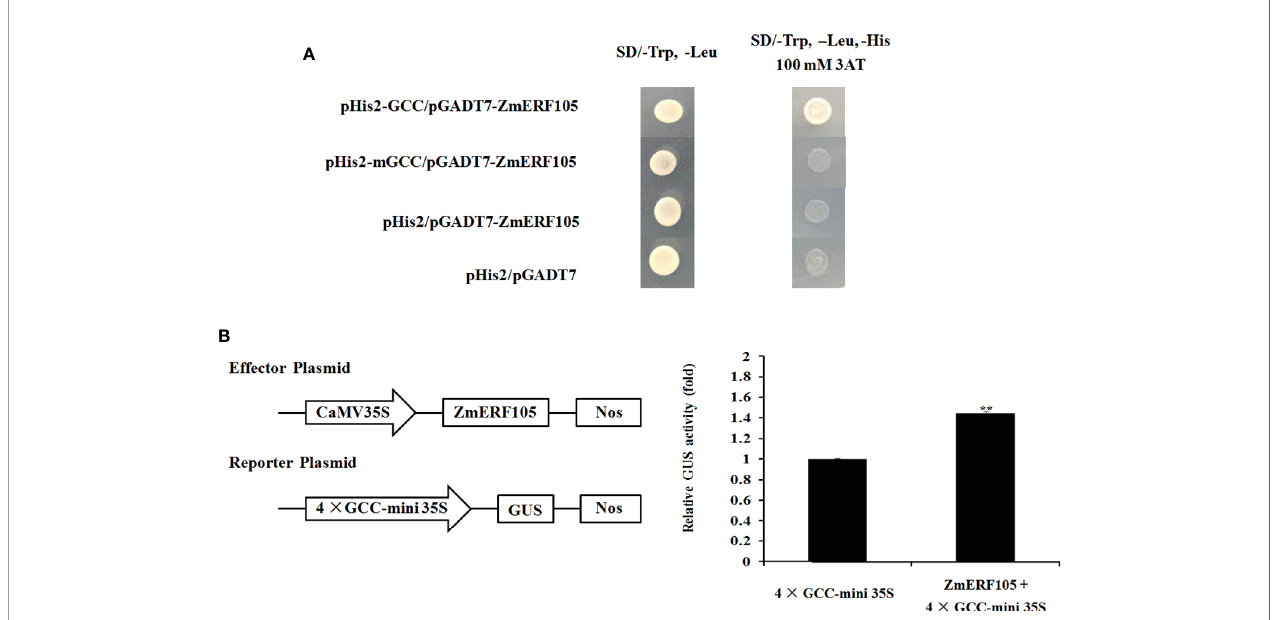
FIGURE 5 | Binding to the GCC-box elements and transcription activity analysis of ZmERF105. (A) The binding activity of ZmERF105 to the GCC-box elements in yeast one-hybrid assay. Yeast cells were selected on SD (-Trp/-Leu) and SD (-Trp/-Leu/-His) media supplemented with 100 mM 3-AT. (B) Transcription activity analysis of ZmERF105 in Arabidopsis protoplasts. The numbers show the fold increase in GUS activity compared with the reporter vector driven by 4× GCC 35S mini promoter alone. The experiment was performed using three biological and technical replicates each and analyzed using Student ’ s t -tests (**P < 0.01). Bars indicate standard error of the mean